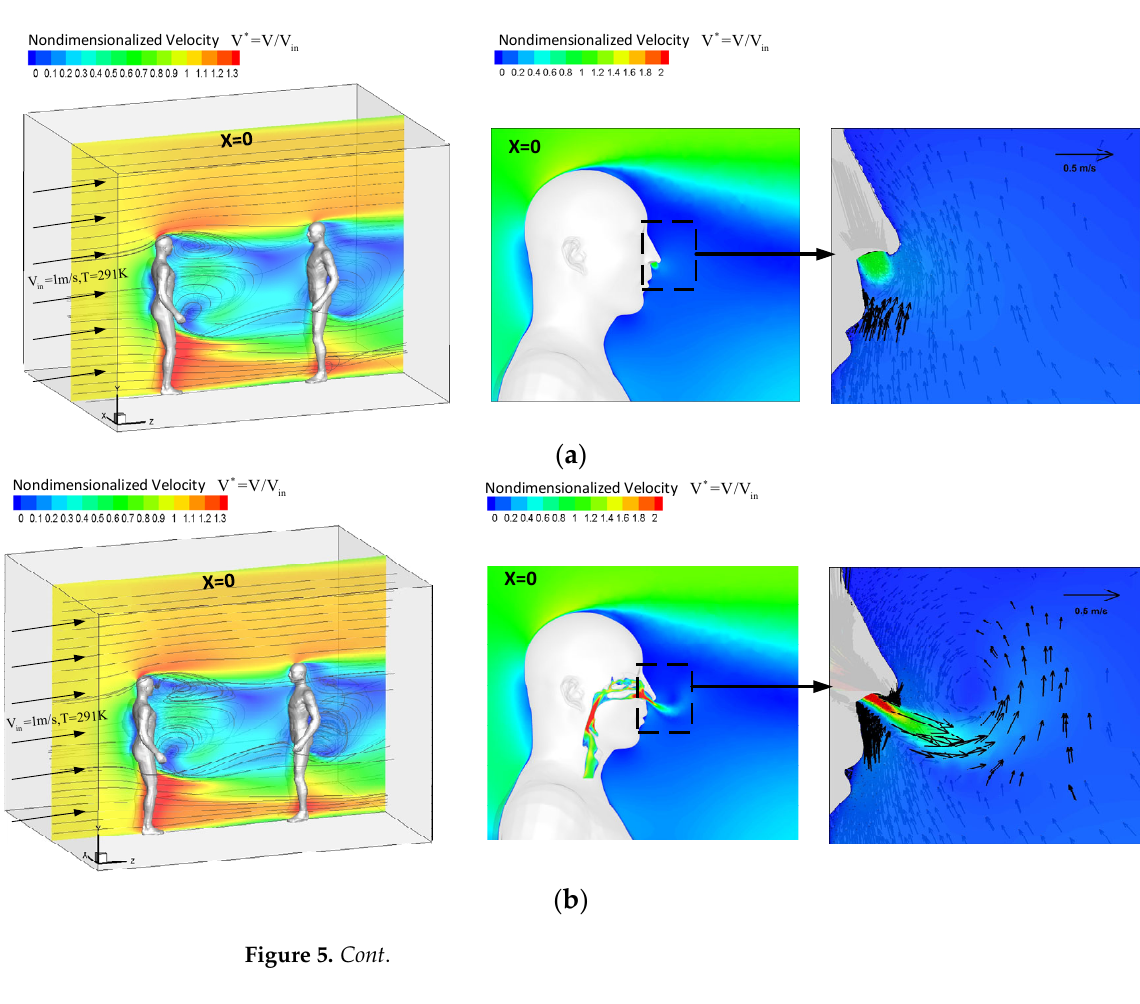
Figure 4. Nebulogram and tangent vector diagram of velocity distribution at nostril: ( a ) V in = 1 m/s, T = 291 K, CA; ( b ) V in = 1 m/s, T = 291 K, NCA.